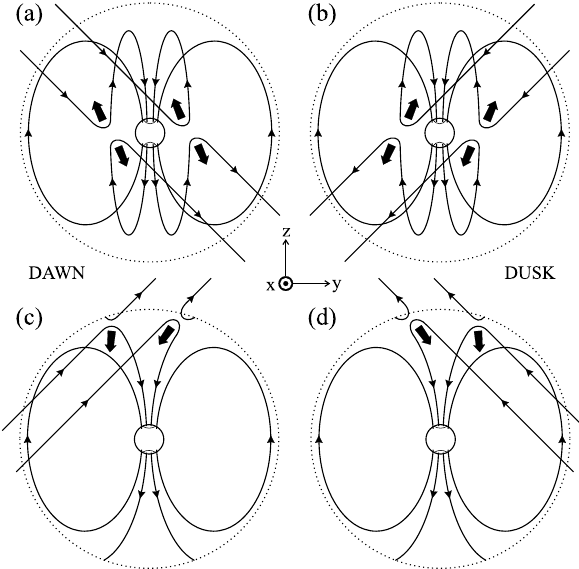
Fig. 2. The asymmetry in the evolution of newly-opened field lines and its dependence on the orientation of IMF B Y for southward IMF ( a and b ), as described by the Svalgaard-Mansurov effect (af- ter Gosling et al., 1990). The asymmetry in the evolution of newly- opened field lines for northward IMF is similarly shown ( c and d ) where reconnection is taking place in the northern hemisphere tail- lobe. Solid lines are magnetic field, dotted lines are the magne- topause boundary and the large arrows show the direction of curva- ture force. Shown in GSM